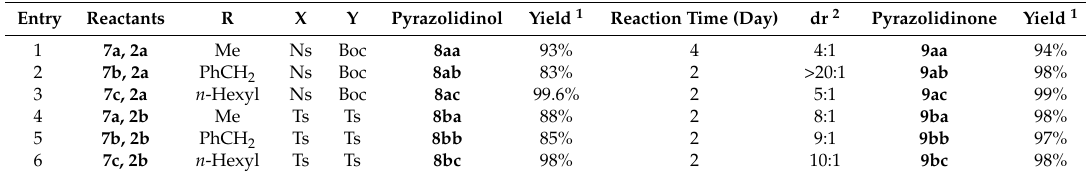
Table 1. Pyrrolidine-catalyzed synthesis of pyrazolidin-3-ols 8aa – 8bc from α -substituted enals 7a – 7c and hydrazines 2a and 2b , and oxidation to the corresponding pyrazolidin-3-ones 9aa – 9bc . Entry Reactants